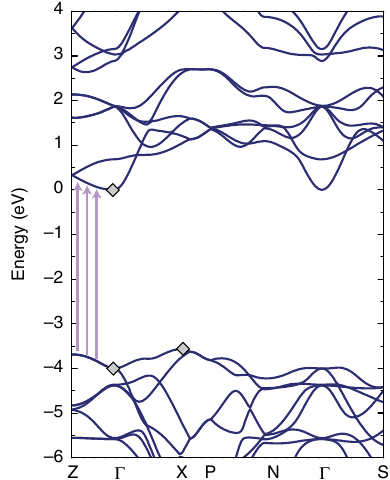
Fig. 5 Calculated electronic structure. Electronic band structure of pristine anatase TiO 2 in the fi rst BZ. The lines indicate the DFT calculations corrected by the GW values. Grey diamond dots indicate the values obtained with the GW corrections at the Γ and X points, while the values along the high symmetry directions are obtained by correcting with linearly interpolated values